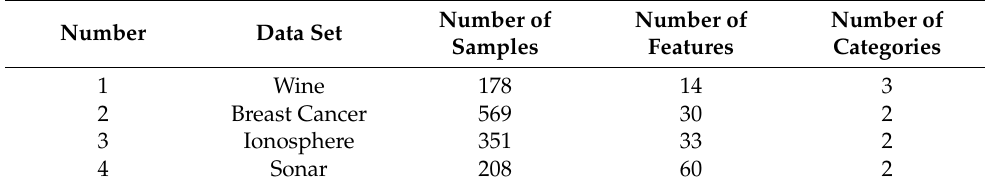
Table 1. Experimental Verification Data Set.